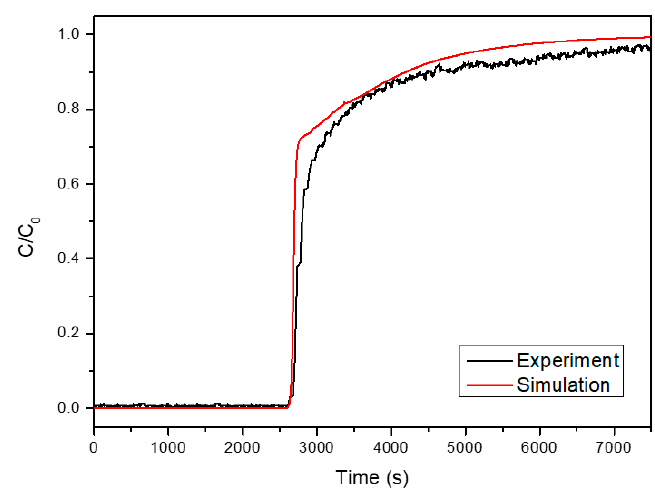
Figure 8. The breakthrough curve for CO 2 .